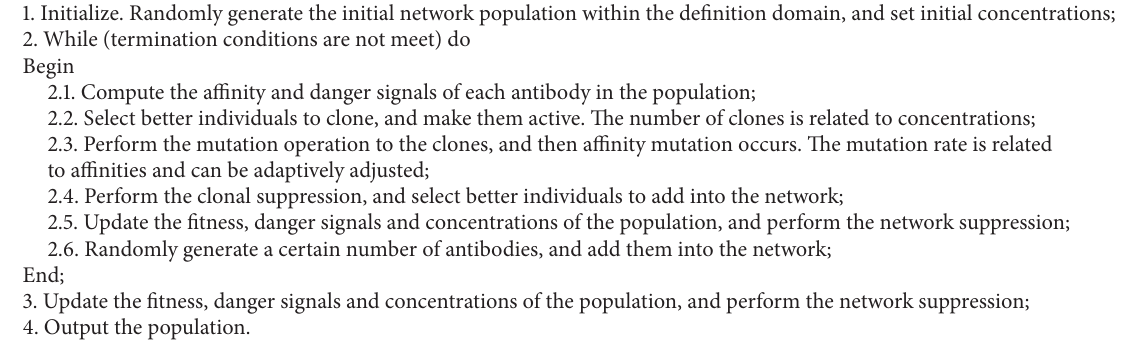
Algorithm 2: The description of